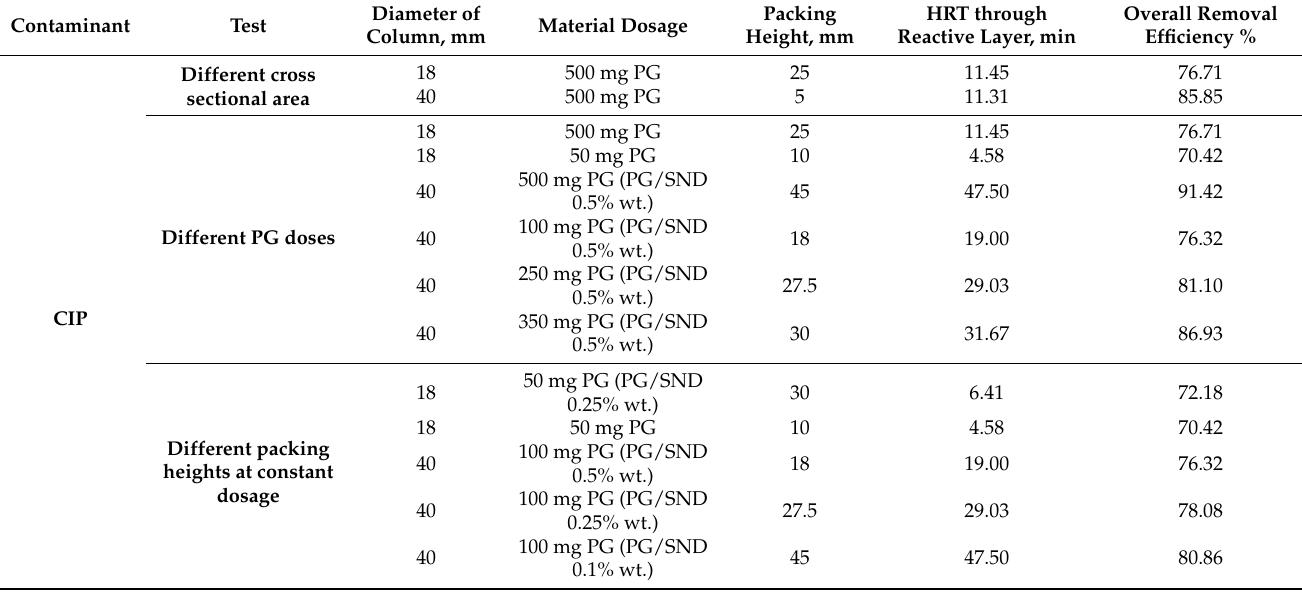
Table 3. Hydraulic retention time and overall removal efficiency of CIP removal by column filters of different cross sectional areas, PG doses, and packing heights at constant dosage. Experimental conditions: ECs-contaminated DW influent adjusted at 10.5 mg/L of EC; room temperature at 22 ± 3 ◦